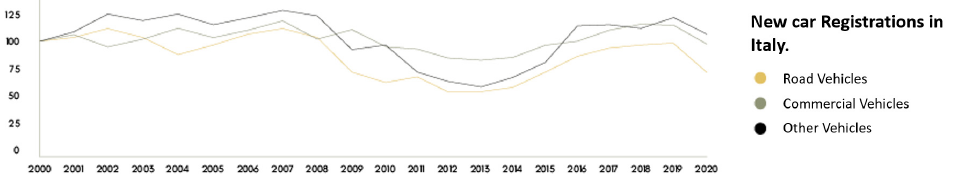
Figure 4. Brand new car sales. A.C.I. statistics.